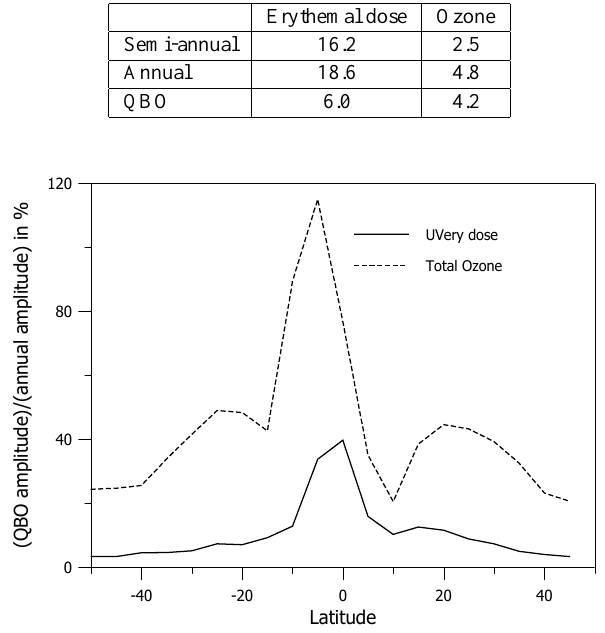
Table 3. Peak-to-peak amplitudes (in % relative to the mean) for the annual, semi-annual and QBO cycles of ozone and erythemal dose at the tropics ( − 5 ◦ ), from TOMS observations, during the period